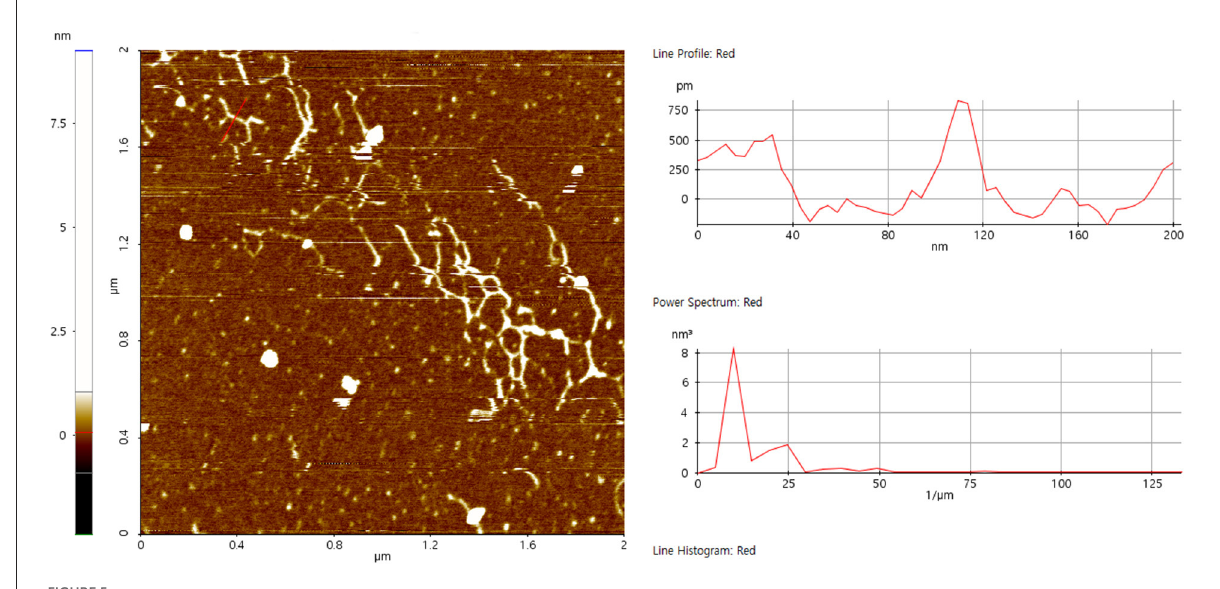
FIGURE5 Atomic force micrographs of